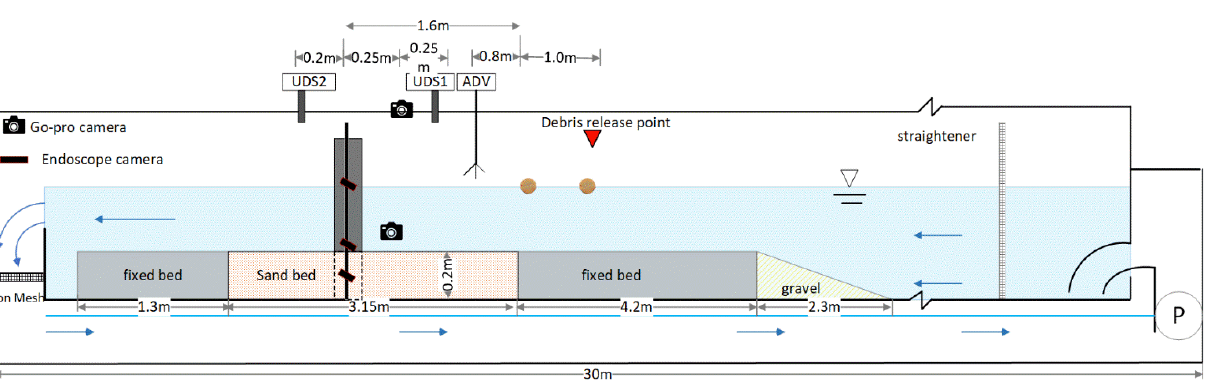
Figure 1. Experimental setting (not at scale). A pier with a diameter D p 0.09 m was placed in the sand bed at the test area